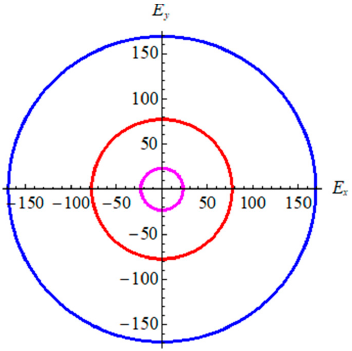
Figure 4. The 2D Young’s modulus for graphyne. Pink line represents α -graphyne, red line represents β -graphyne, and blue line represents γ -graphyne.